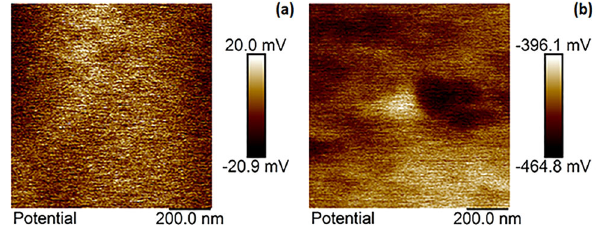
Fig. 8 Measurement of surface potential. KPFM surface potential micrographs of a AQ-glass, and b HT-2h samples indicating higher surface potential in the case of HT-2h sample in comparison to that of the AQ-glass